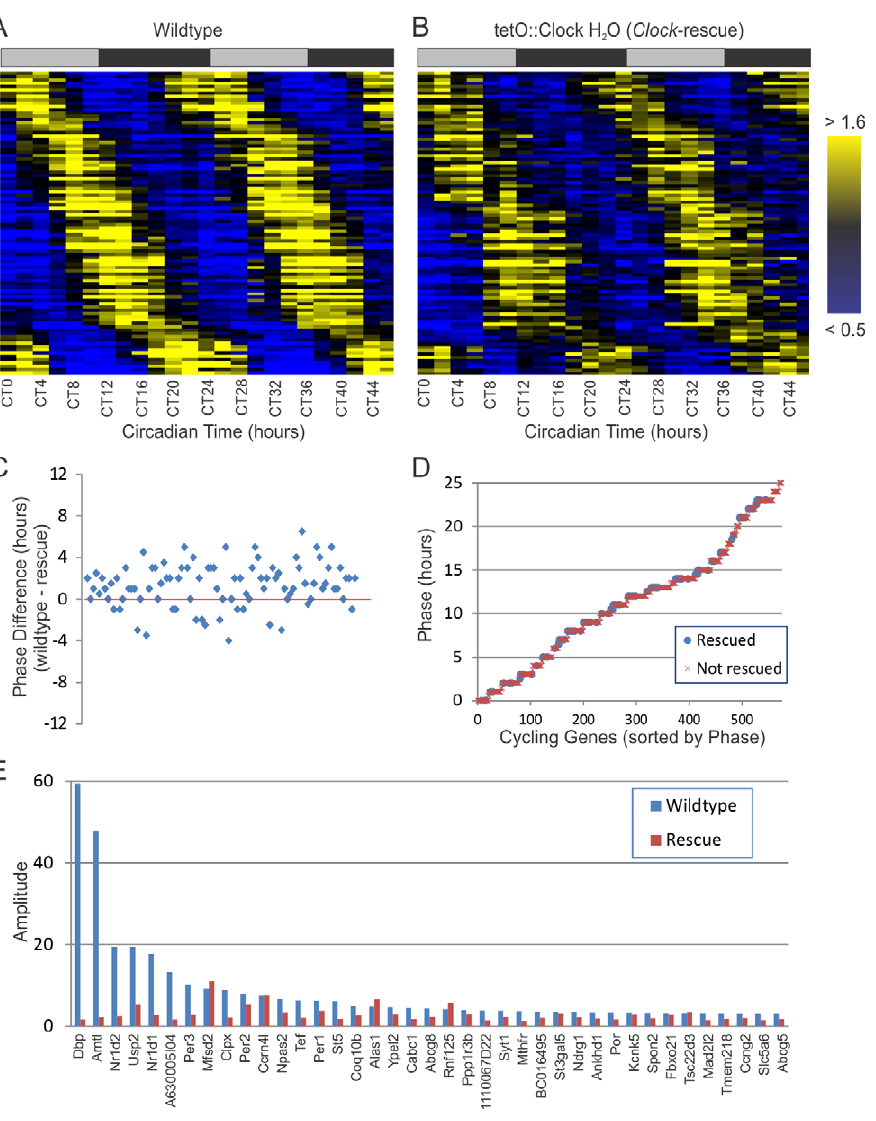
Figure 4. Clock -rescue restores appropriate phase to circadian output genes. 24-hour cycling genes (p , 0.0011 for both genotypes, period $ 20 hours, N=92) identified in both wildtype (A) and Clock -rescue animals (B) were median-normalized, sorted by phase, and plotted as a heatmap (yellow=high expression, blue=low expression). Each row represents the temporal expression of one cycling gene common to both datasets. Shaded bars above the heatmaps represent subjective day and night. In (C), the phase difference between wildtype and Clock-rescue is plotted for all 92 rescued genes, ordered by amplitude in wildtype. On average, there is a , 1.5 h phase advance in the Clock-rescue samples. Panel (D) shows the phases of every cycling gene identified in wildtype, including those rescued in Clock-rescue animals (blue circles) and those not rescued (red x’s). There was no bias in the phase of rescued genes. Panel (E) shows the amplitudes of high-amplitude cycling genes (AMP . 3.0) in wildtype versus Clock -rescue animals. Several genes have been re-plotted from Figure 2E for the sake of completeness.